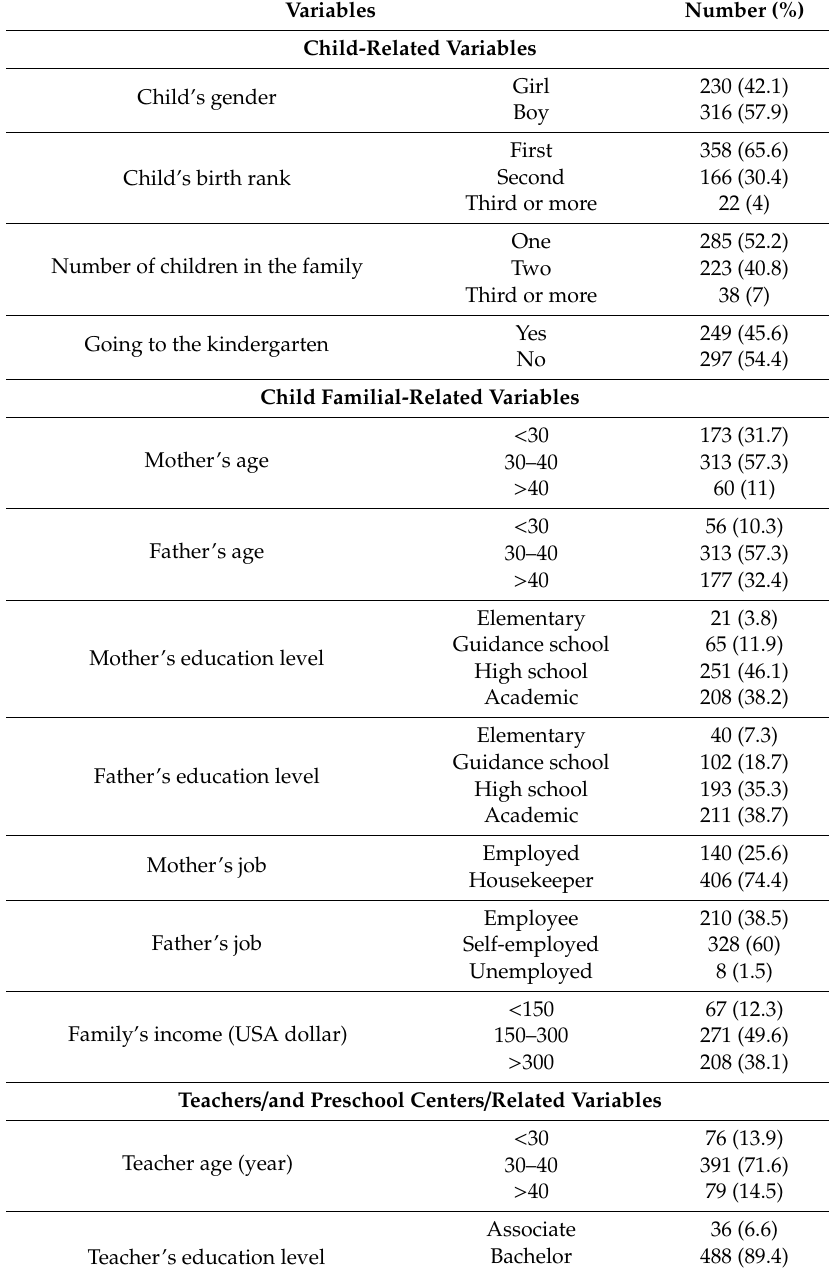
Table 1. The participants’ characteristics according to demographic and social